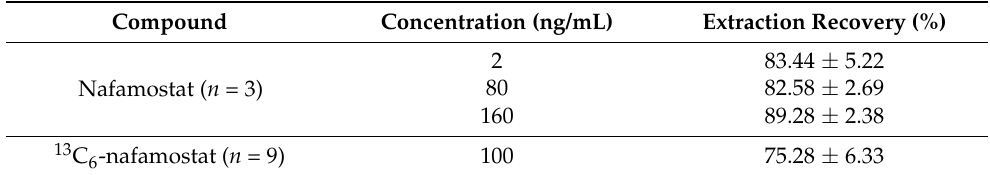
Table 3. Extraction recovery of nafamostat and 13 C 6 -nafamostat (IS) in the rat plasma (mean ± SD, n = 3). Compound